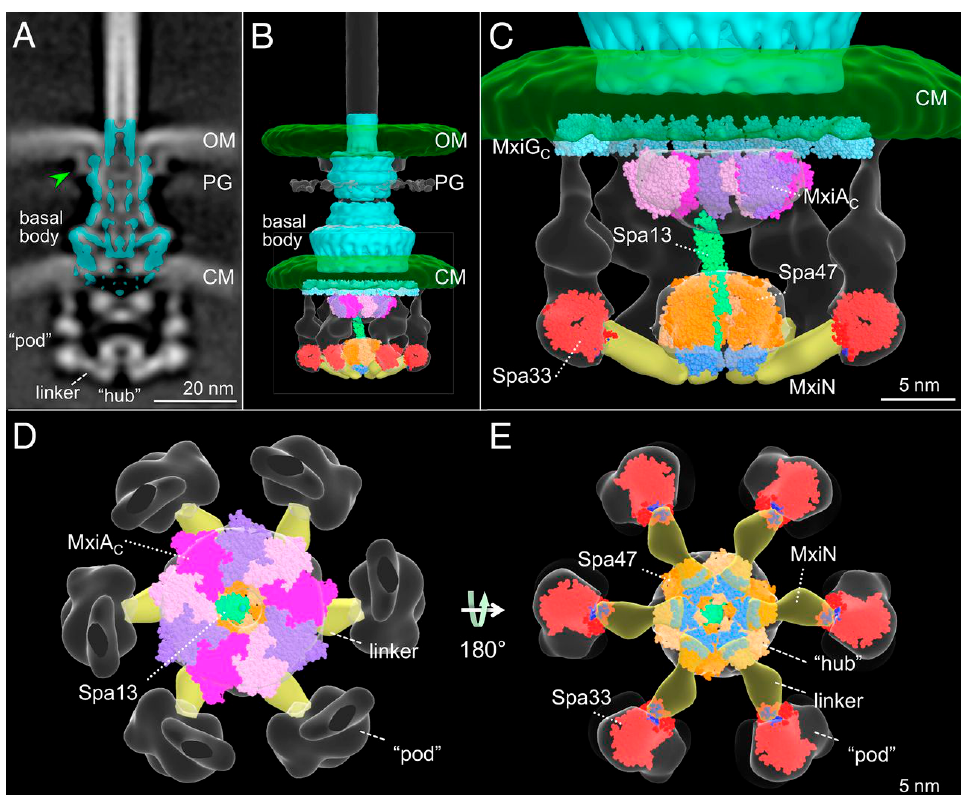
Figure 2. The first reported model of the in situ Shigella injectisome with sorting platform. ( A ) The isolated Shigella basal body (cyan) is fit onto the intact injectisome map and shown as a cross-section. The central portion of this cut-away of the core (cyan) contains the export apparatus (contained inside the inner membrane ring). Above this is the inner rod that eventually connects to the needle filament that crosses the outer membrane (OM). ( B ) A surface rendering of the isolated basal body is fit into the injectisome with the cytoplasmic portion of MxiG (SctD) and the sorting platform structures fit into the cytoplasmic densities. The extra densities shown include the OM, inner or cytoplasmic membrane (CM) peptidoglycan (PG), the sorting platform and an additional element (green arrow) near the OM. ( C ) Models of selected cytoplasmic proteins are fit into the rendering map. These include the cytoplasmic portion of the export gate (MxiAc, PDB-4A5P), Spa13, Spa47, MxiN and Spa33. ( D ) A top view of nonameric MxiAc with portions of the soring platform visible beneath. ( E ) A bottom view that more clearly shows the positions of Spa47, MxiN and Spa33. Structures used for this first model of the in situ Shigella injectisome include the Thermus thermophilus V-ATPase for Spa47 (orange, PDB-3J0J), Salmonella FliJ for Spa13 (green, PDB-3AJW), the cytoplasmic domain of Salmonella SctD for MxiGc (cyan, PDB-3J1W), the Thermatoga maritima FliN tetramer for Spa33 (red, PDB-1YAB). The MxiN density is shown in yellow with the interaction with Spa33 in blue and the interaction with Spa47 in cyan ( E ). Adapted with permission from [28], PNAS, 2015.